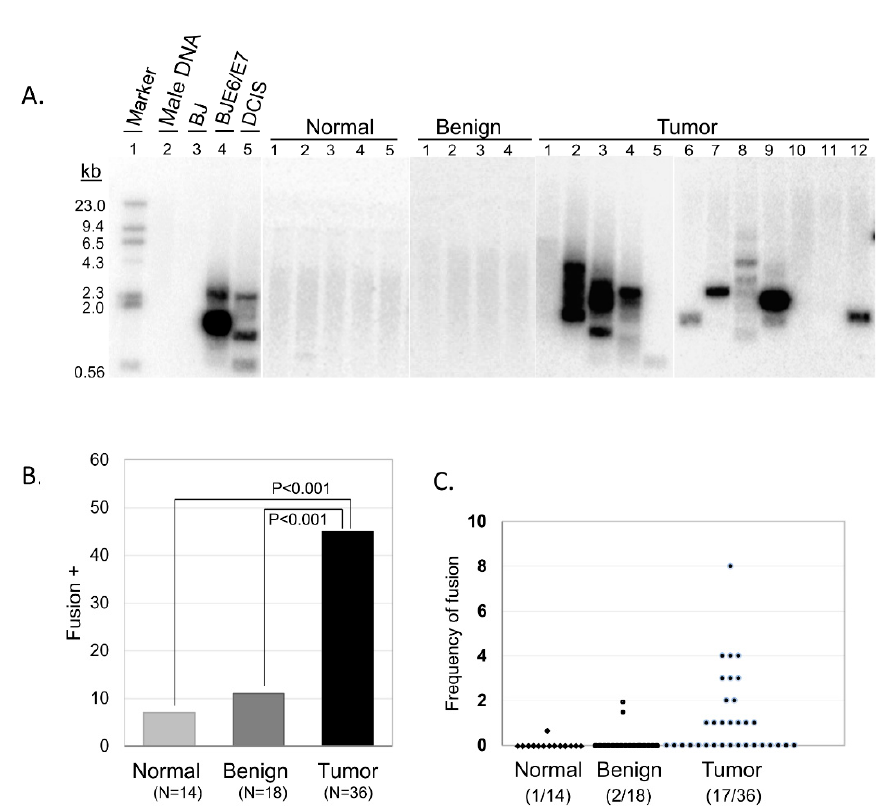
Figure 1. Telomere fusions in the ovarian tissue samples. ( A ) Southern blot analysis using 32 P-labled [TTAGGG] 4 probe. Five representative samples are shown for normal and benign, and 12 for tumor tissue samples. Normal male DNA and BJ foreskin fibroblast cells are used as negative controls, while BJ cells expressing the human papillomavirus type 16 E6 / E7 oncoproteins (BJ E6 / E7) DNA and ductal carcinoma in situ (DCIS) DNA are used as positive controls. ( B ) The percentage of fusion-positive samples. Standard t-test analysis is shown. ( C ) Frequency of telomere fusions where each dot represented one individual with the number of telomere fusion Southern bands per 500ng genomic DNA from five TAR-Fusion PCRs.